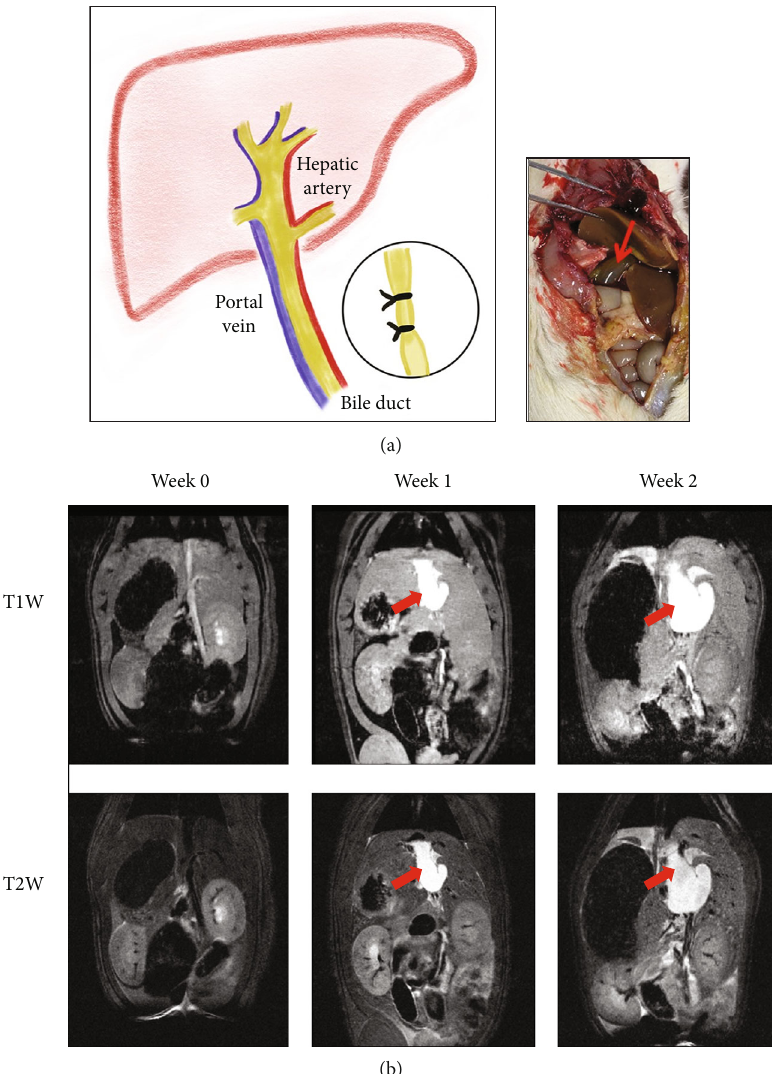
Figure 1: An example of bile duct ligation (BDL) in a rat model. (a) The scheme of bile duct ligation for inducing liver fi brosis. (b) The magnetic resonance images of a representative rat before and after BDL. The red arrows indicate the dilated bile